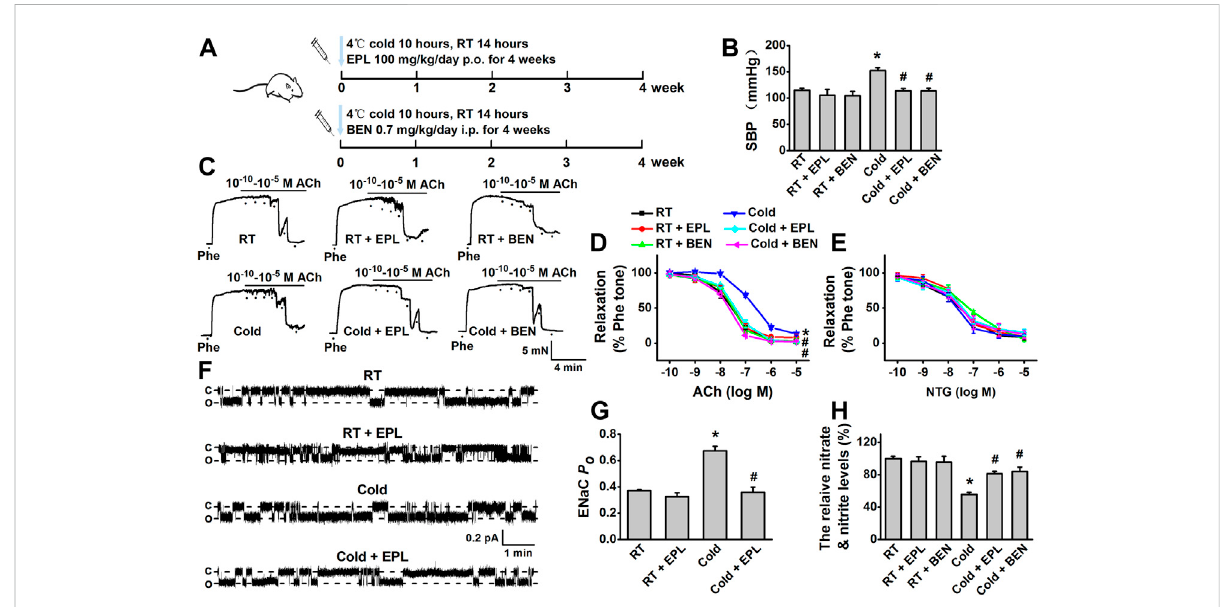
FIGURE 3 ColdexposureinducedelevationofbloodpressureandimpairmentofEDRwerehinderedbyeithereplerenoneorbenzamil. (A) Ratswerekept under the 4 ° C/RT condition at a 10 h/14 h cycle and received the dosage of 100 mg/kg/day eplerenone (EPL, MR antagonist) or 0.7 mg/kg/day benzamil (BEN, EnNaC blocker) for 0 – 4 weeks. (B) CIH was reversed by pharmacological inhibition of aldosterone/MR or EnNaC ( n = 5 – 8 for each group; * p < 0.05 vs. control; # p < 0.05 vs. cold exposed group). (C) Representative traces of EDR of MA rings; the rings were, respectively, isolated from the rats exposed to room temperature (RT), RT application of EPL, or BEN for 4 weeks, cold exposure, or cold exposure application